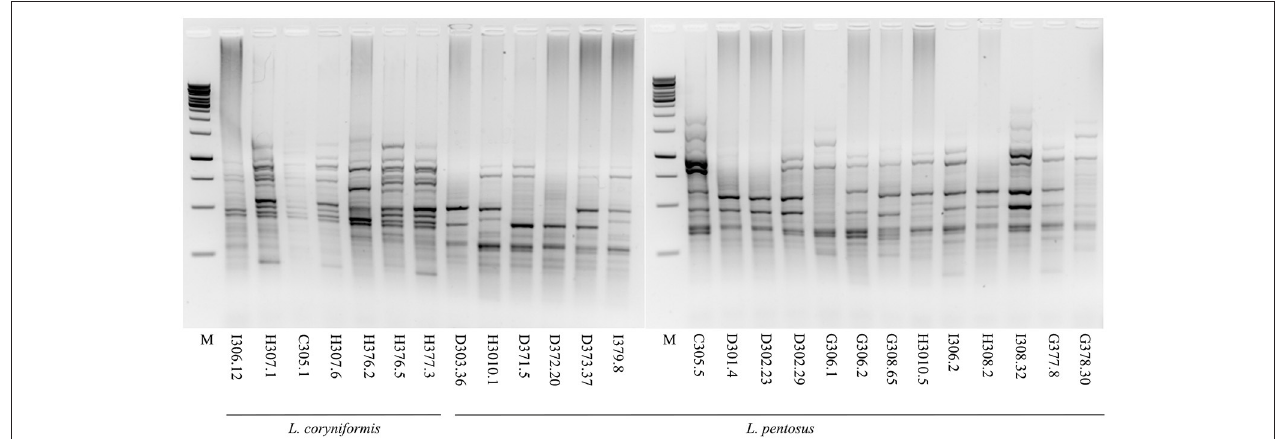
FIGURE 1 | Strain typing of the selected L. pentosus and L. coryniformis isolates by rep-PCR. Agarose gel electrophoresis of GTG 5 rep-PCR fingerprinting profiles of L. coryniformis and L. pentosus strains. M: 1kb DNA ladder (Microzone,